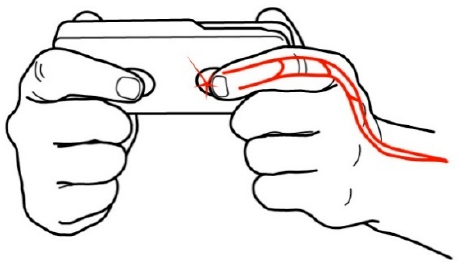
Figure 2. Recording of the ECG and the photoplethysmography image using the CardioQVARK ® smartphone case. The index fingers are placed at the ECG electrode (left) and at the photoplethysmograph monitor (right).